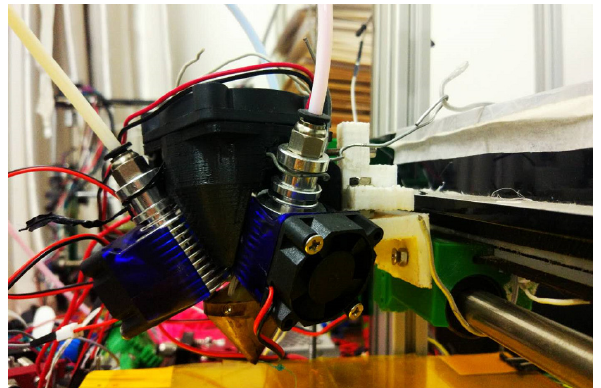
Figure 2. The structure of color 3D printer nozzle.